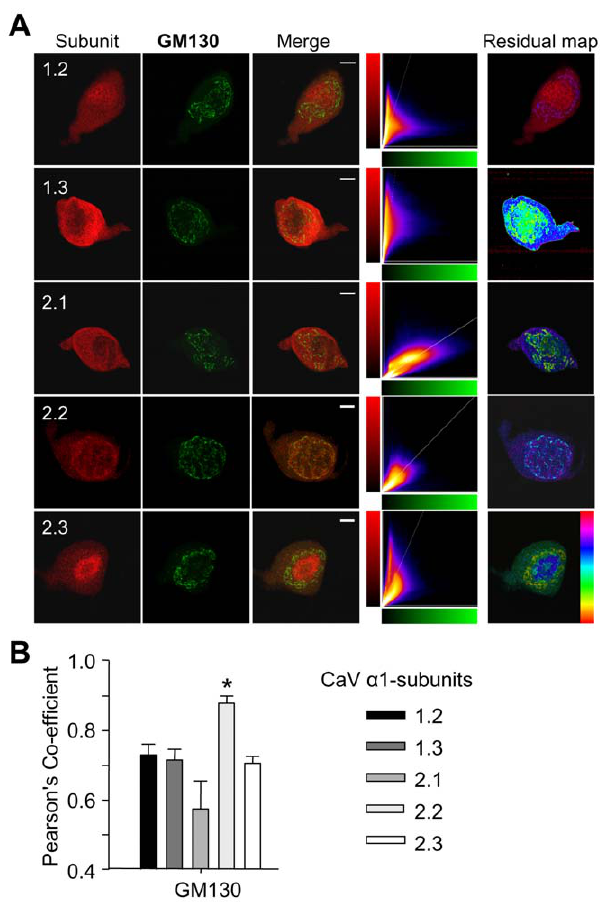
Figure 4. Ca 2 + channel distribution in relation to the Golgi apparatus. ( A ) Immunostaining for Ca v a 1 subunits (red) and the Golgi marker GM130 (green) in acutely-dispersed supraoptic neurons. There was strong co-localisation of Ca v 2.2 with GM130, a marker for the Golgi apparatus. No fluorescent labelling was detected when primary antibodies were omitted or incubated with a five-fold excess of control immunogen before being exposed to the cells (not shown). ( C ) Quantification of covariance data of GM130 and one of the five a 1- subunits using Pearson’s coefficient values (n=5 per group) showed a significant difference between the co-localisation of GM130 and Ca v 2.2 versus the other a 1-subunits. Means 6 S.E.M. * P , 0.05, one-way ANOVA followed by Holm-Sidak post-hoc test vs Ca v 2.2. Scale bars 10 m m.